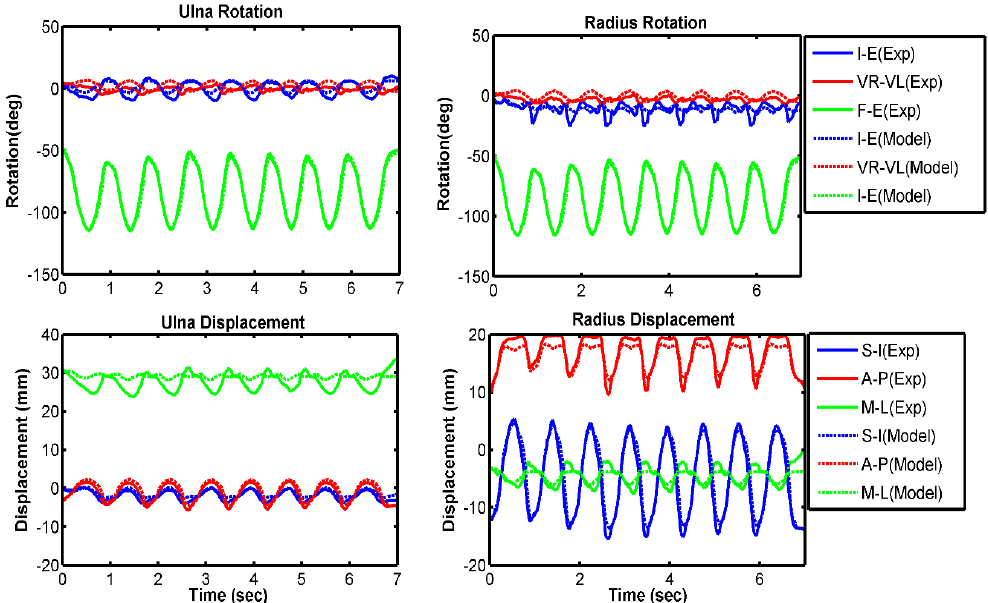
Figure 6. Relative bone kinematics for experiment and model prediction for the free velocity trial. Increasing trend of the graph indicates more internal rotation for I–E, more valgus rotation for VR–VL, and more extension for F–E. Similarly, it indicates more superior translation for S–I, more anterior translation for A–P, and more medial translation for M–L. Decreasing trend of the graph indicates the